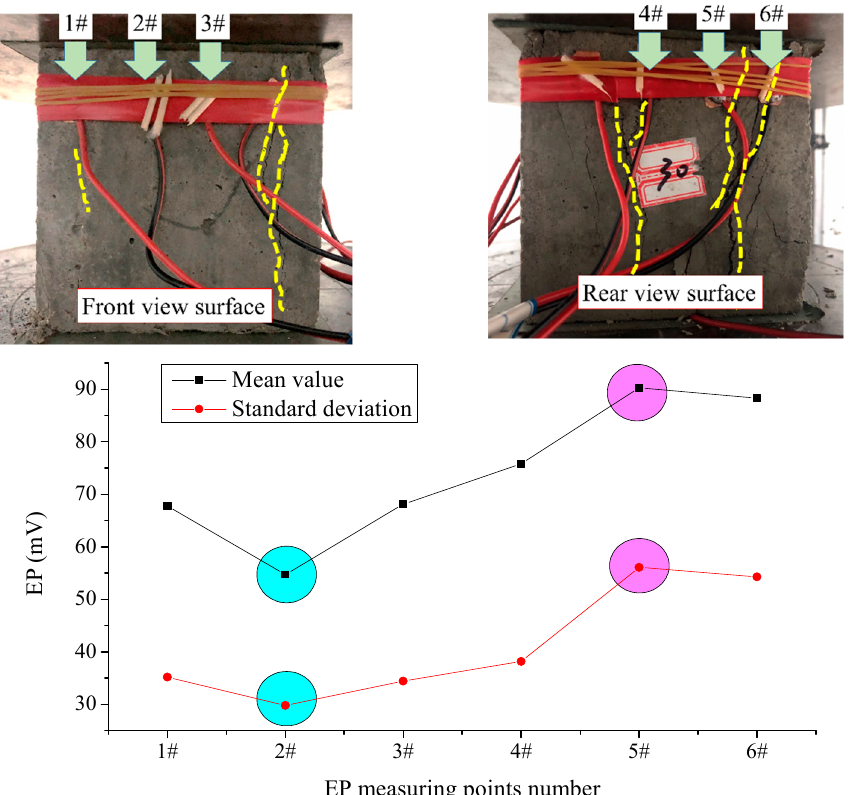
Figure 10. Statistics of mean and standard deviation of the EP signal at different measuring points of the concrete specimen.